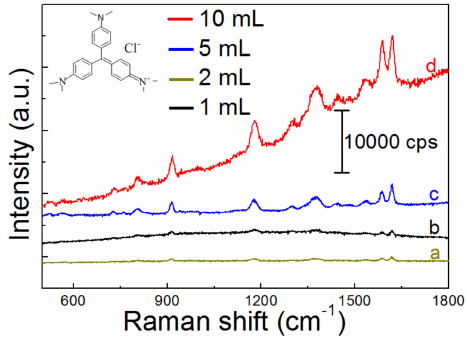
Figure 6. SERS enhancements of CVs (concentration: 10 − 6 ; soaking time: 15 min) on the prepared substrates activated by seed I and with adding different amounts of mixed solution of AA and Na 3 Cit with curves ( a – d ) corresponding to 1 mL, 2 mL, 5 mL, and 10 mL,